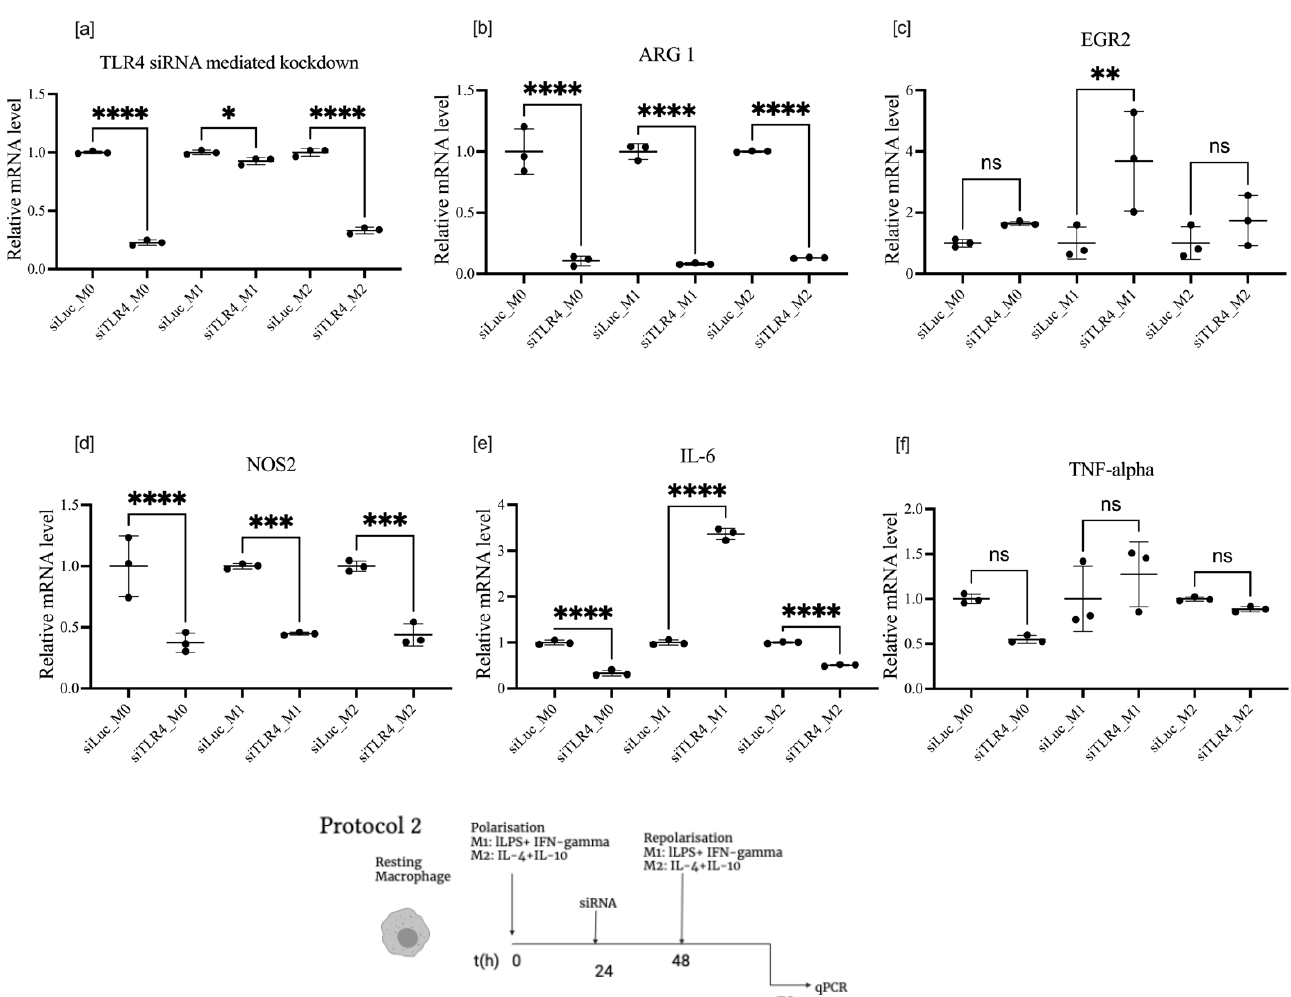
Figure 4. mRNA expression of TLR4 ( a ), ARG1 ( b ), EGR2 ( c ), NOS2 ( d ), IL-6 ( e ), and TNF- α ( f ), after TLR4 knockdown in macrophages treated according to protocol 2. Data are presented as mean ± SD, n = 3 [ns; not significant; * p < 0.05; ** p < 0.01; *** p < 0.001; **** p < 0.0001].